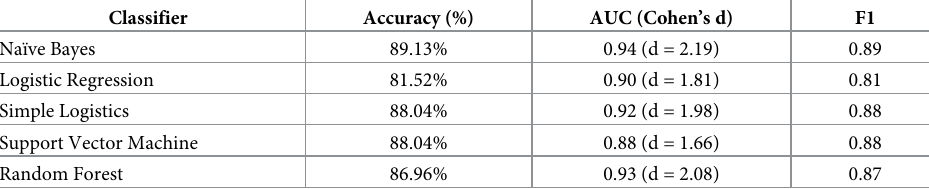
Table 7. Accuracies as measured by % correct, AUC, and F1 obtained by five different ML